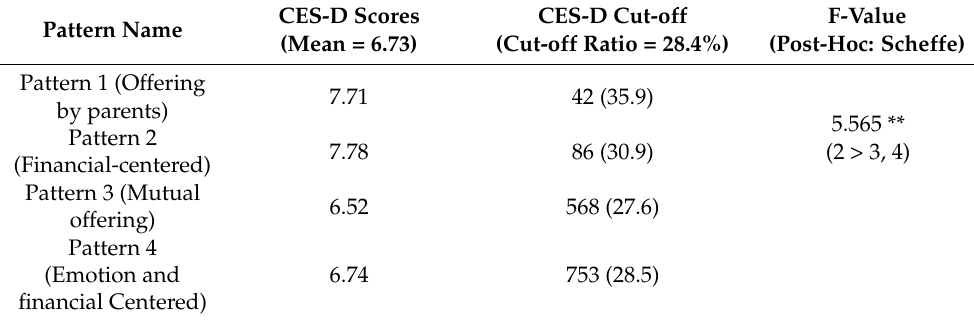
Table 5. Mean Comparison of CES-D Scores by